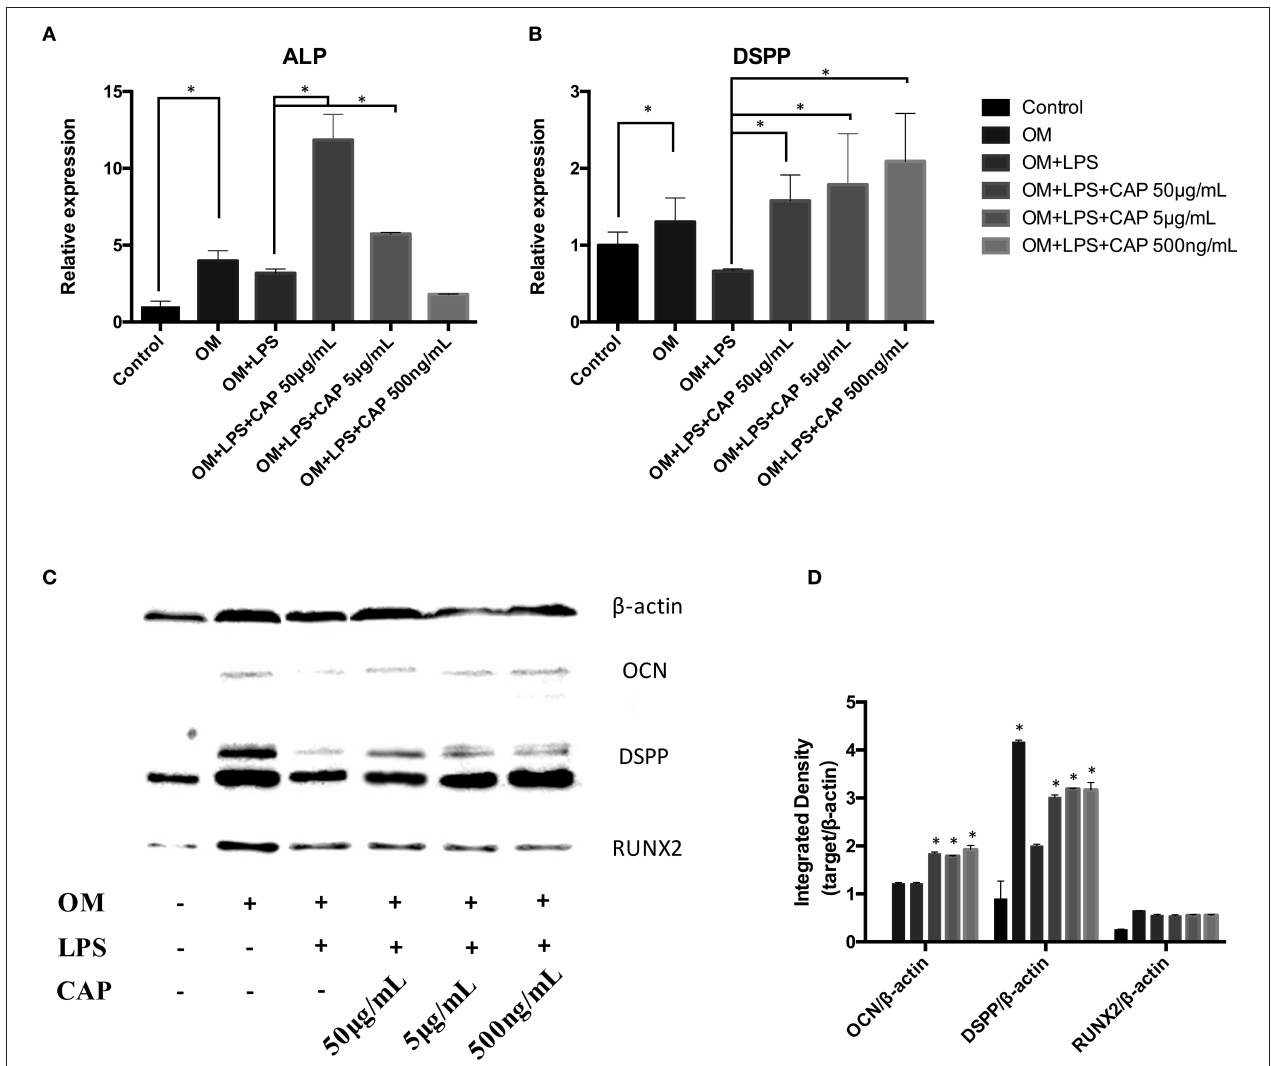
FIGURE 5 | Quantitative PCR analysis of the odontoblast differentiation markers ALP (A) and DSPP (B) , and western blot analysis of osteo/odontogenic markers (C) . The integrated density of bands were analyzed by ImageJ (D) . The molecular weights of marked protein were listed followed: β -actin 45kD, OCN 50-55kD, DSPP 37-40kD, RUNX2 55-62kD. The asterisks indicate significant differences between groups (* p ≤ 0.05 one-way ANOVA and LSD comparison test) and the bars represent the standard deviation of three